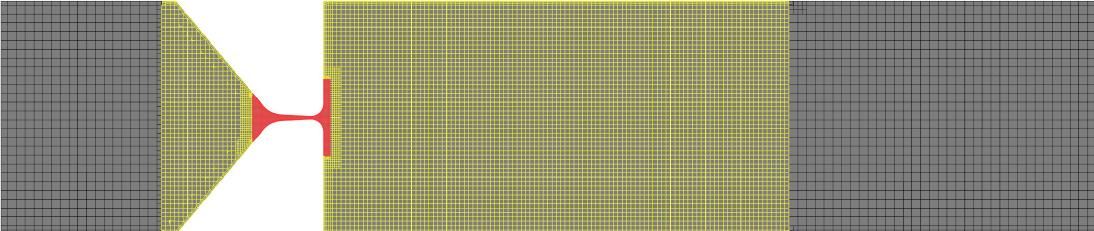
Figure 4. Principle structure of the finest mesh. Gray: cells with base size. Yellow: Cells with basic refinement. Red: Cells with glottis